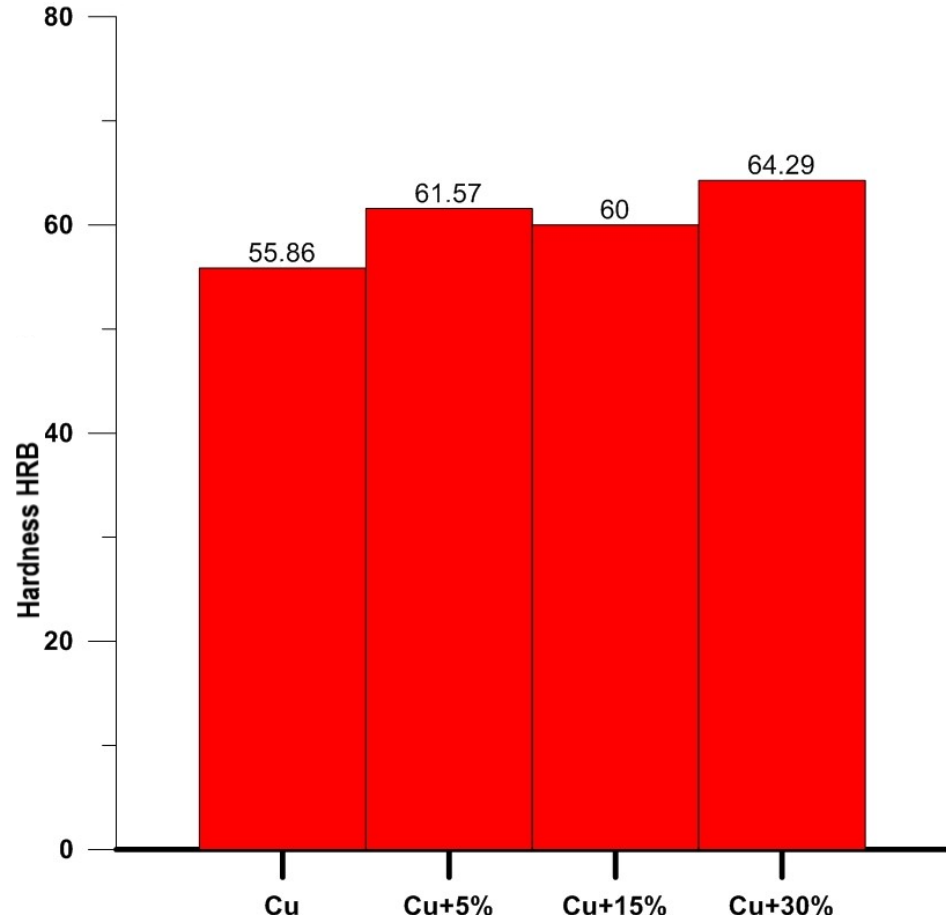
Figure 7. The hardness of composites with tufted densification in the matrix at a pressure of 1200